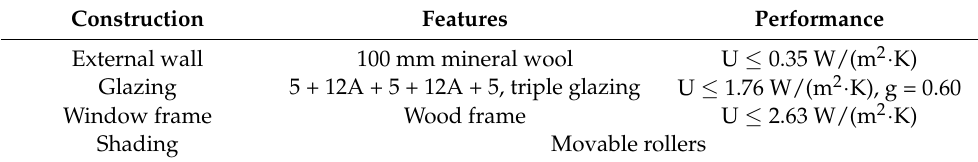
Table 6. Envelope construction.